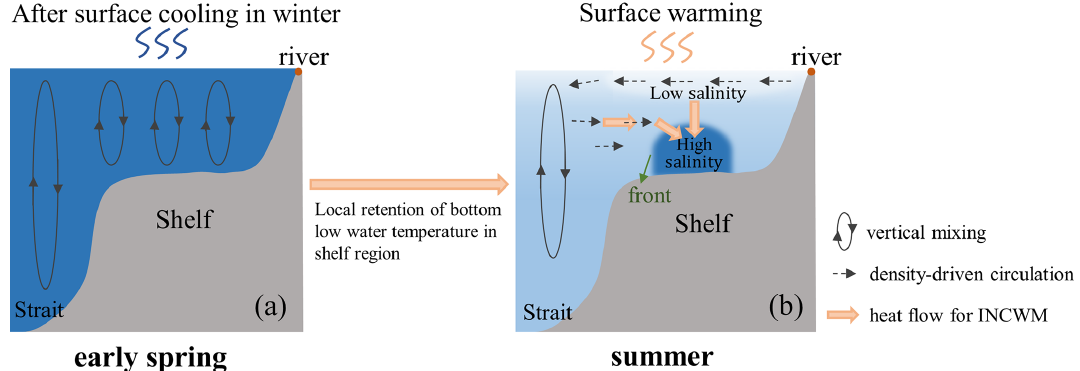
Figure 6. A schematic diagram of seasonal evolution of INCWM from early spring to summer, which is drawn from references Takeoka (2002), Yu et al. (2016), and Yu and Guo (2018). Low water temperature is indicated by dark blue while high water tempera- ture by light blue.